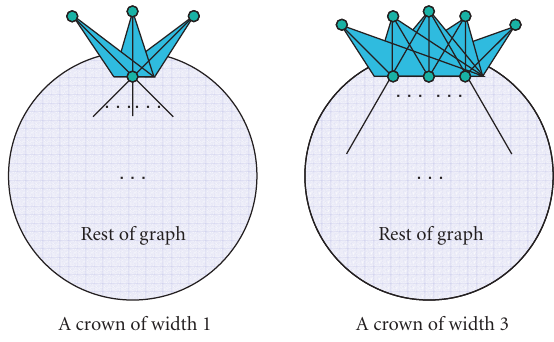
Figure 3. Sample crown decompositions.